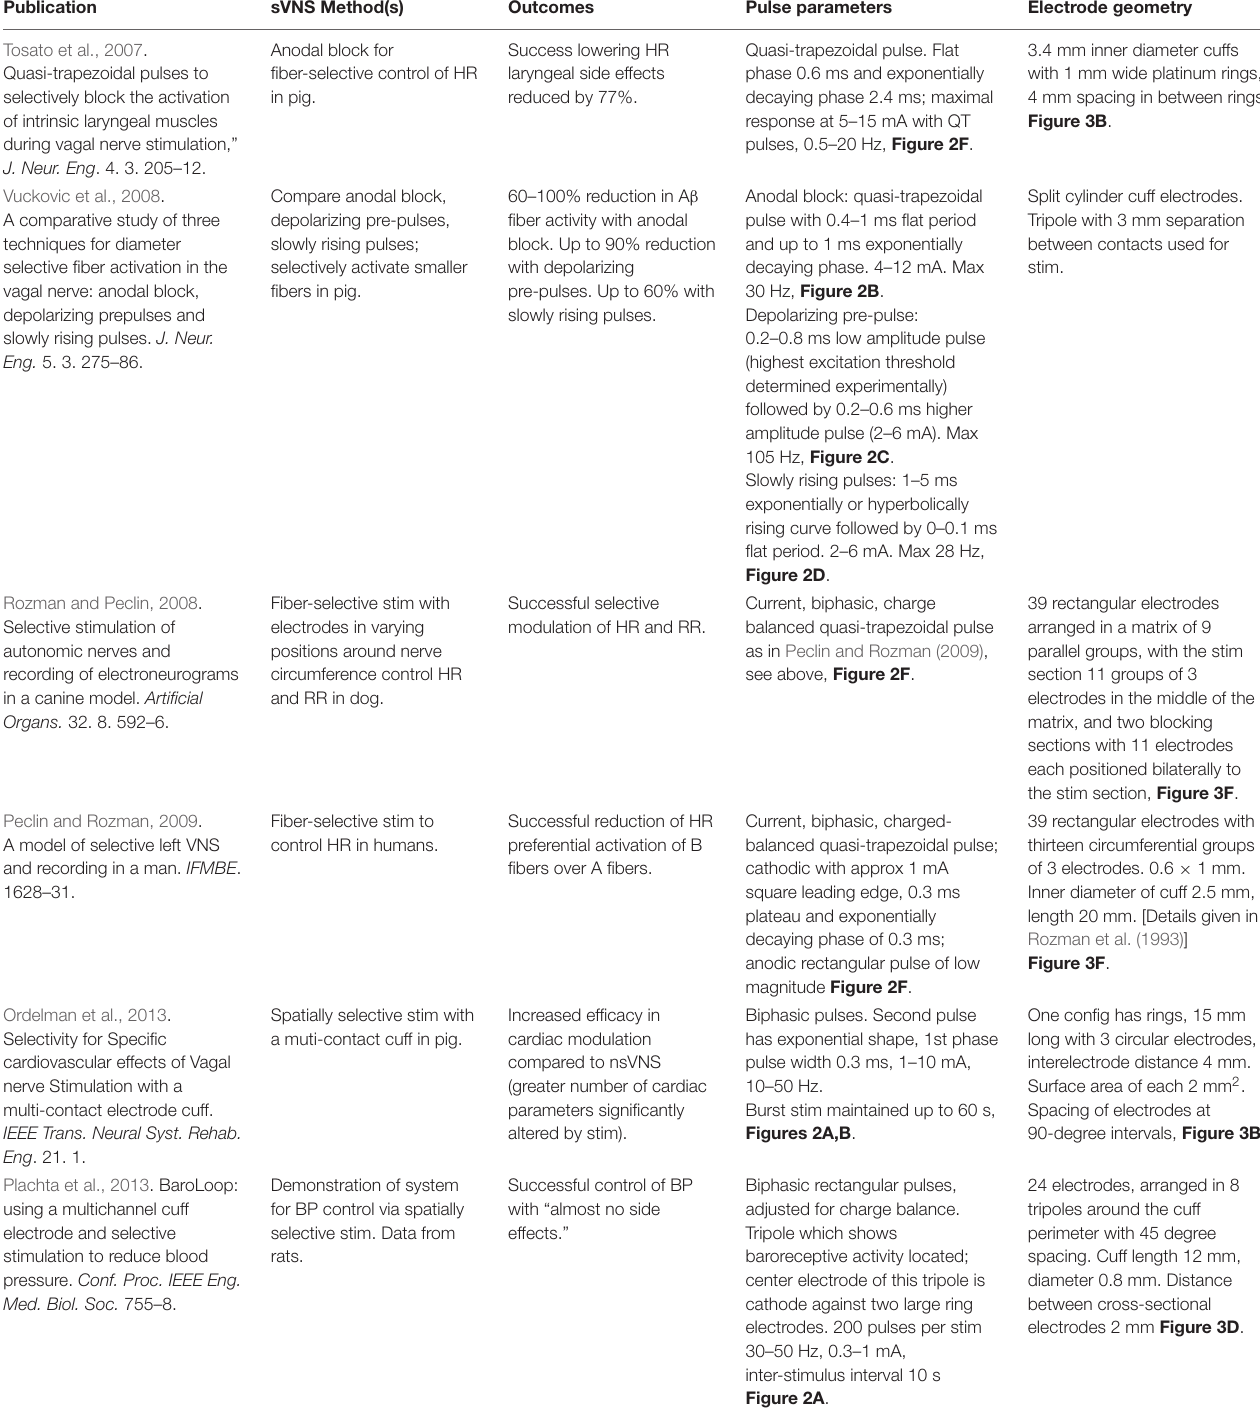
electrodes 2 mm Figure 3D